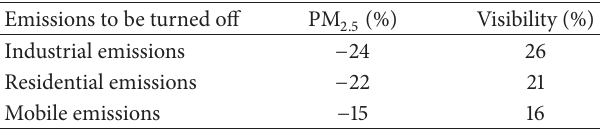
Table 5: Percentage changes of simulated PM 2.5 concentrations and visibility during heavy polluted periods after turning off industrial, residential, and mobile emissions in